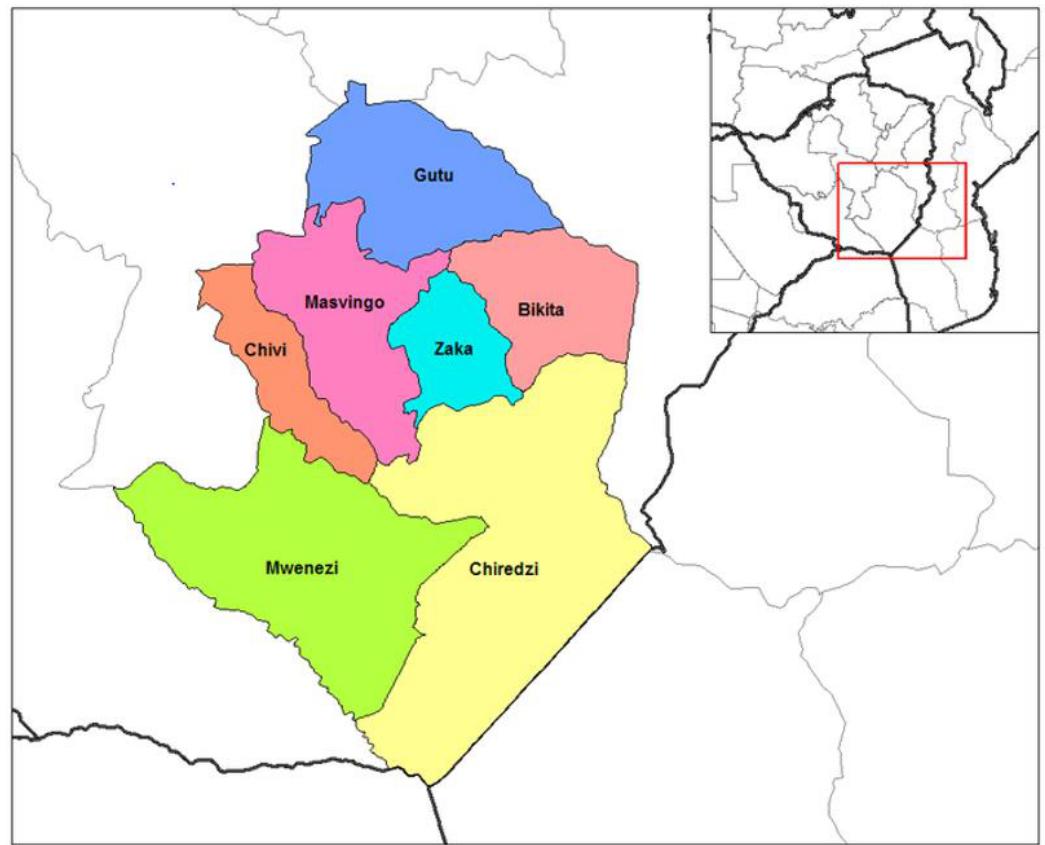
Figure 1. Masvingo Province of Zimbabwe. Source: Sabastain [17].